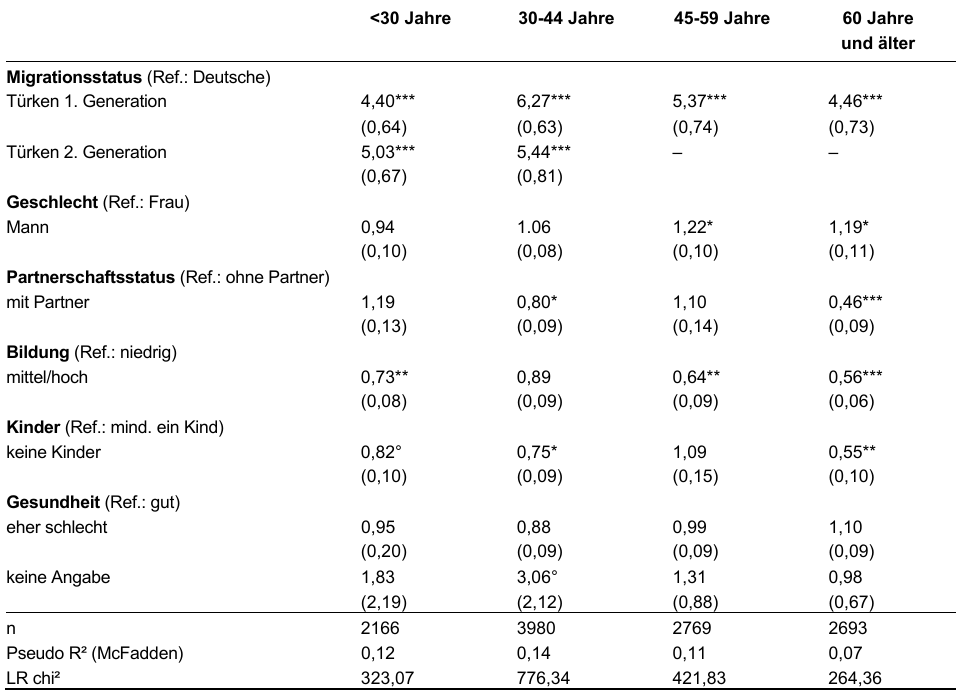
Tabelle 4b : Logistische Regression (OR) zur Zustimmung hinsichtlich der abhängigen Variable „Eltern aufnehmen“ nach